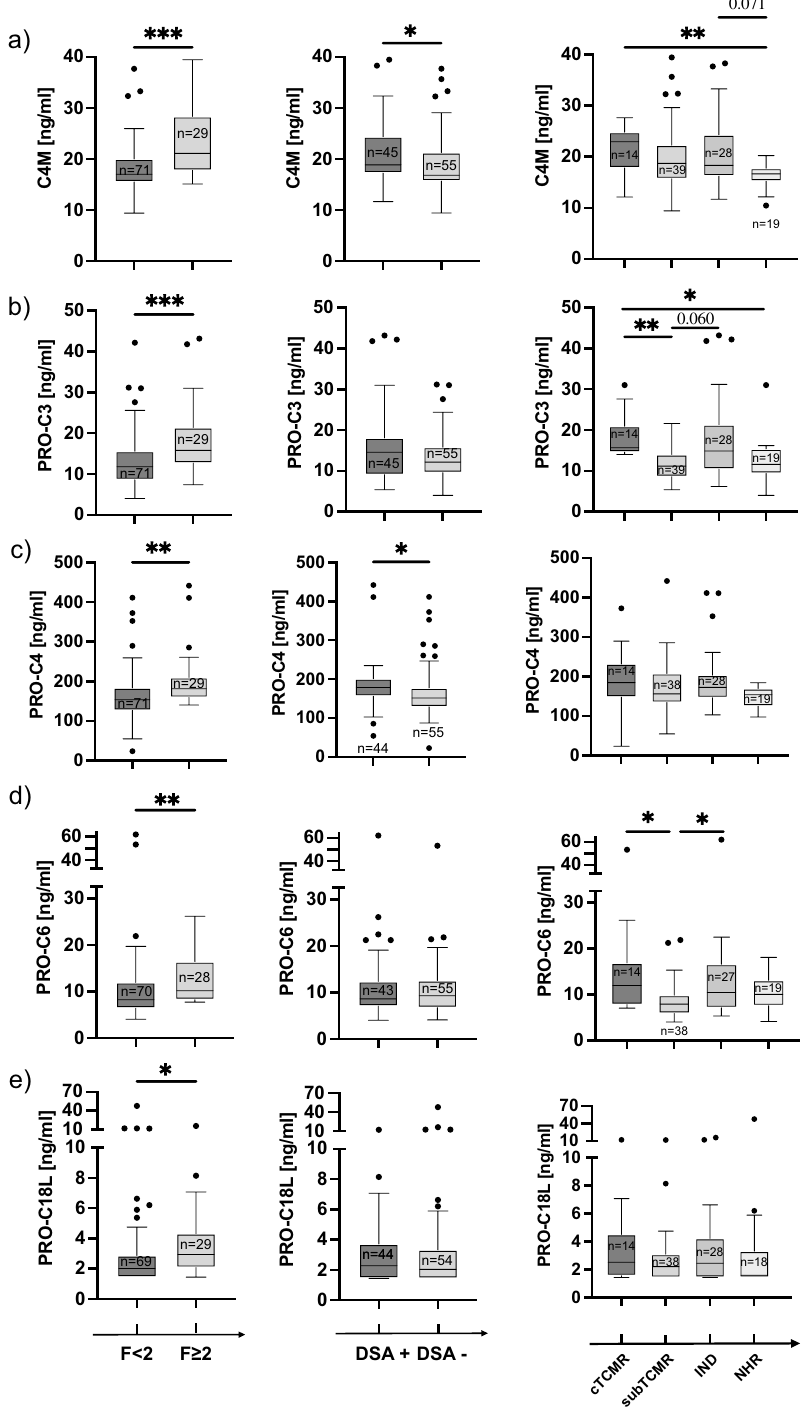
Figure 4. Correlation of ECM biomarkers with clinical phenotypes. Tukey Boxplots showing differences in biomarker levels between significant fibrosis (≥ F2) and no significant fibrosis (< F2) (left panel), differences between DSA positive patients (DSA+) and DSA negative (DSA−) patients (middle panel) and differences in biomarker levels based on histopathological classification of T cell-mediated rejection (TCMR), subclinical T cell-mediated rejection (subTCMR), other graft injury (IND) and no histological rejection (NHR). Differences are shown for C4M ( a ), PRO-C3 ( b ), PRO-C4 ( c ), PRO-C6 ( d ) and PRO-C18L ( e ). Two groups were compared using Mann–Whitney-U test. More than two groups were compared using Kruskal–Wallis test and Bonferroni’s post-hoc test. *indicates p < 0.05; **indicates p < 0.01; ***indicates p <